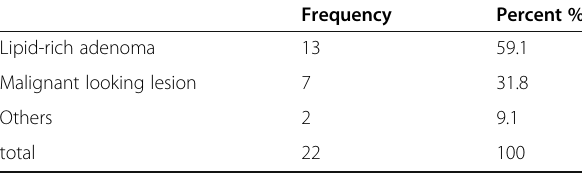
Table 2 MRI diagnosis of adrenal lesions in study population Frequency Percent % Lipid-rich adenoma 13 59.1 Malignant looking lesion 7 31.8